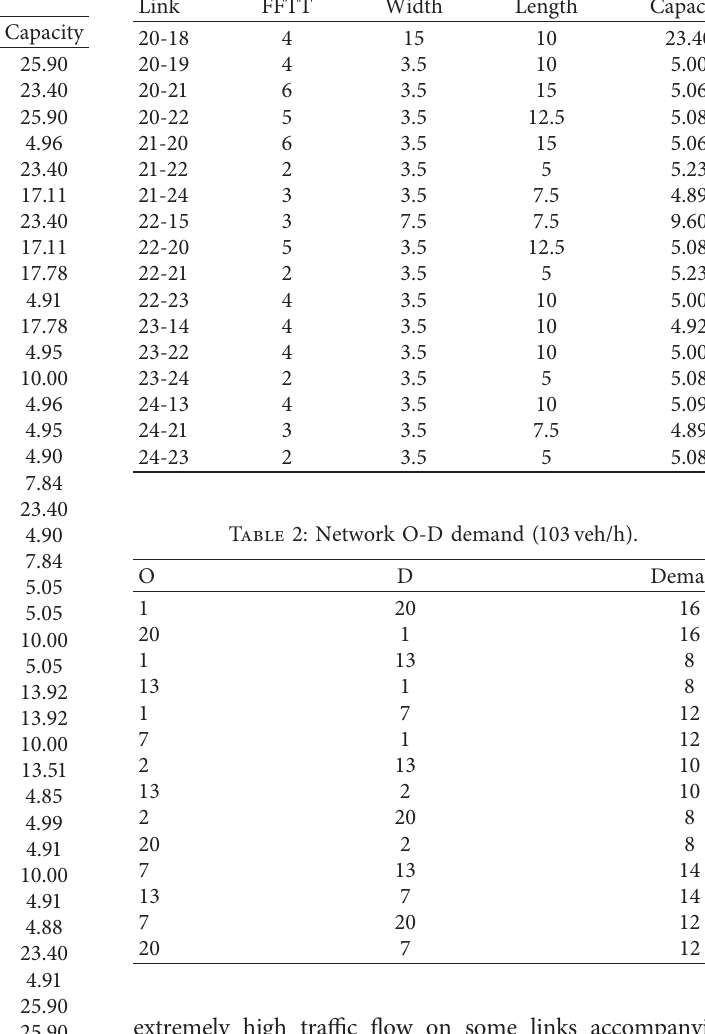
Table 1: Link characteristics: FFTT (min), width (meter), length (mile), and capacity (103veh/h).